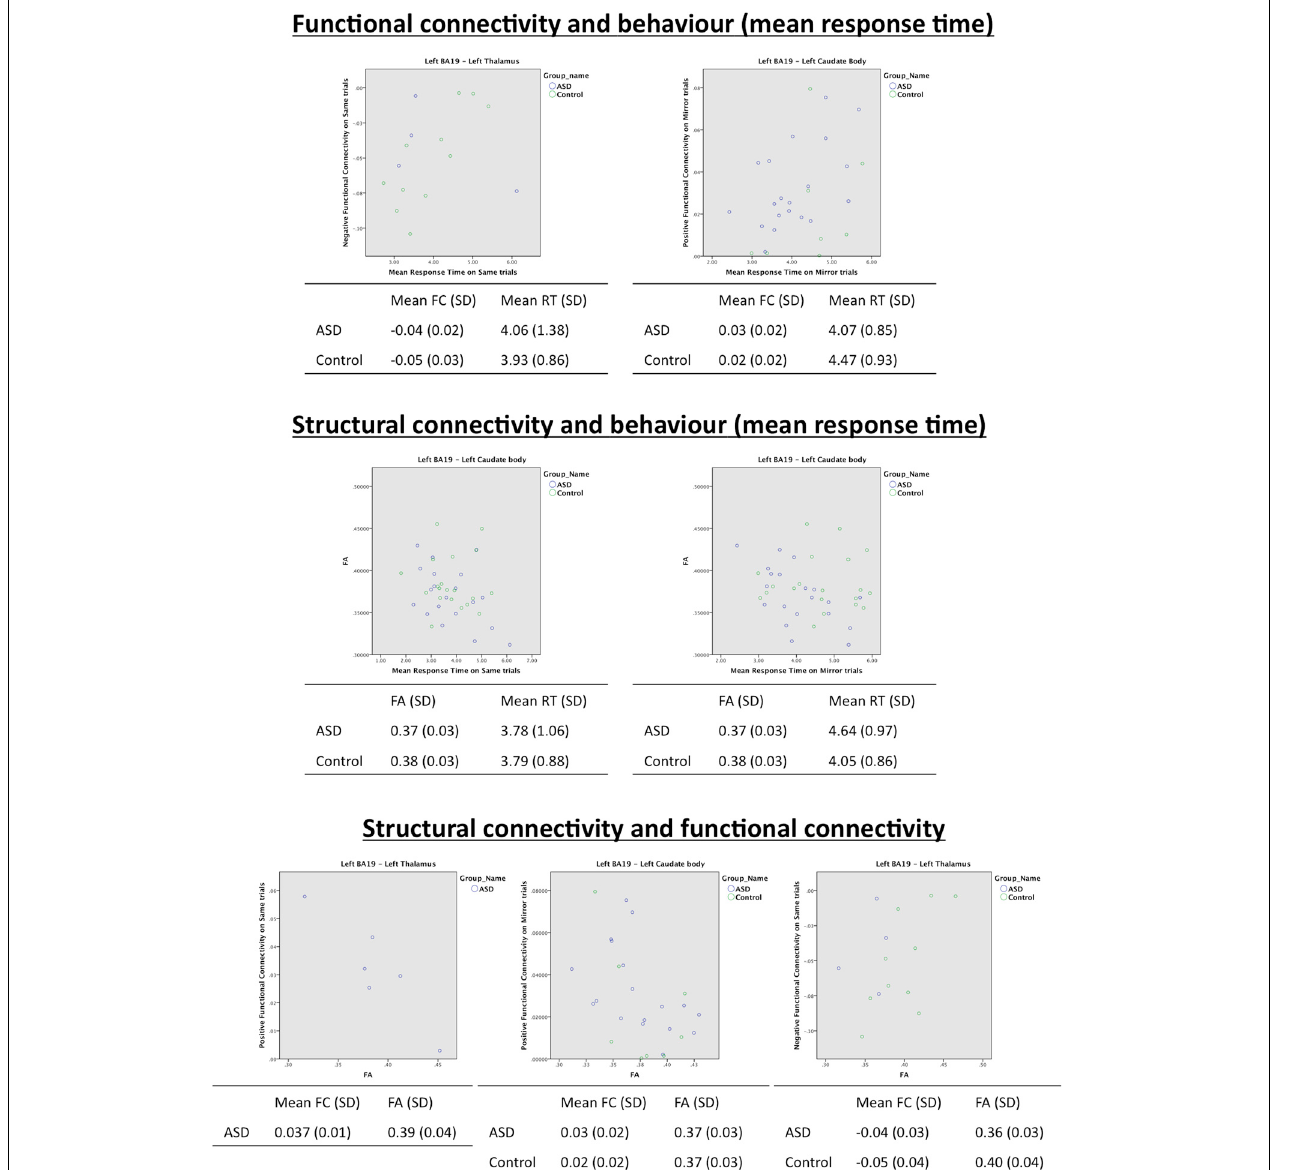
FIGURE 6 | Scatterplots of correlation analyses showing significant relationships between functional connectivity, structural connectivity and